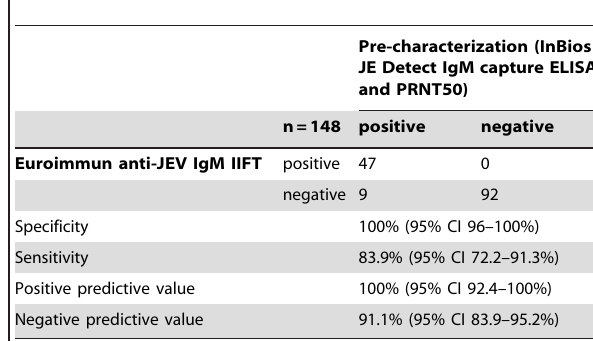
German blood donors